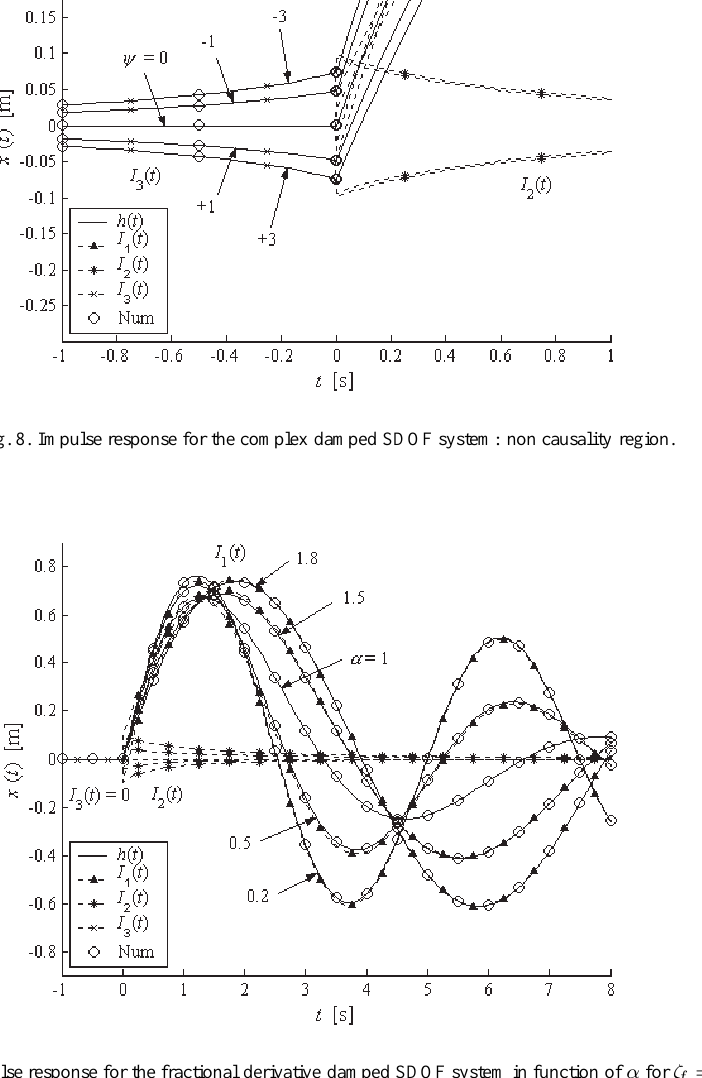
Fig. 9. Impulse response for the fractional derivative damped SDOF system in function of α for ζ f = 0 . 3